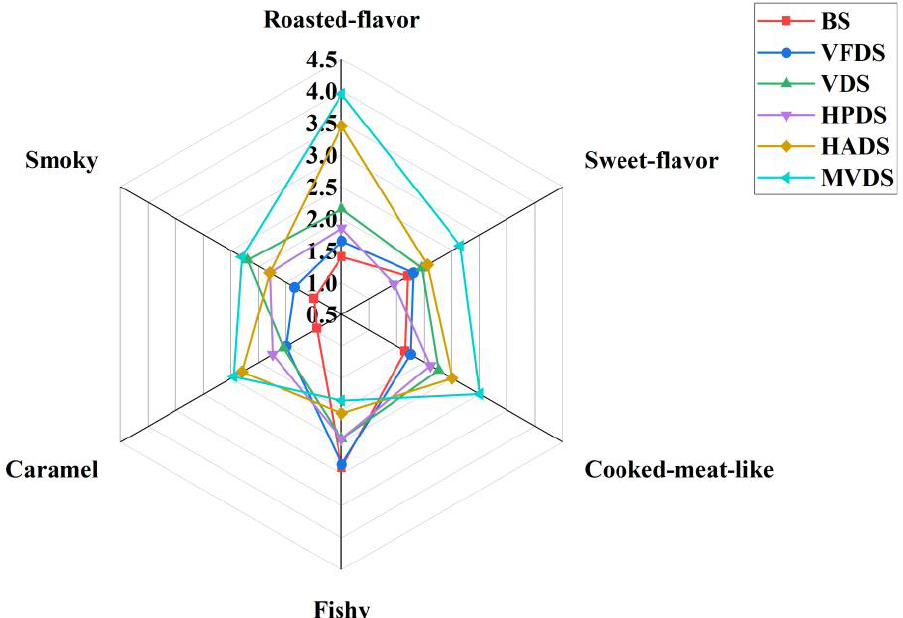
Figure 3. Sensory evaluation of flavor characteristics of different dried shrimps. BS: blanching shrimp; VFDS: vacuum freeze-dried shrimp; VDS: vacuum-dried shrimp; HPDS: heat pump-dried shrimp; HADS: hot air-dried shrimp; MVDS: microwave vacuum-dried shrimp.